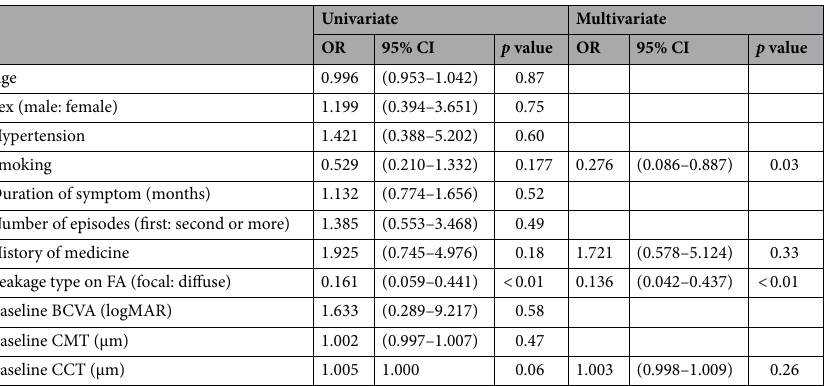
Table 4. Univariate and multivariate analysis of factors associated with complete resolution of subretinal fluid at 6 months after selective retina therapy. OR : odds ratio; CI : Confidence interval.